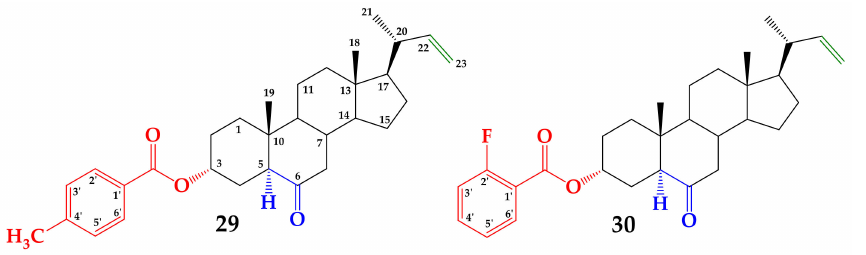
Figure 3. Structures of derivatives 29 and 30 and numbering of aromatic carbon atoms used in this